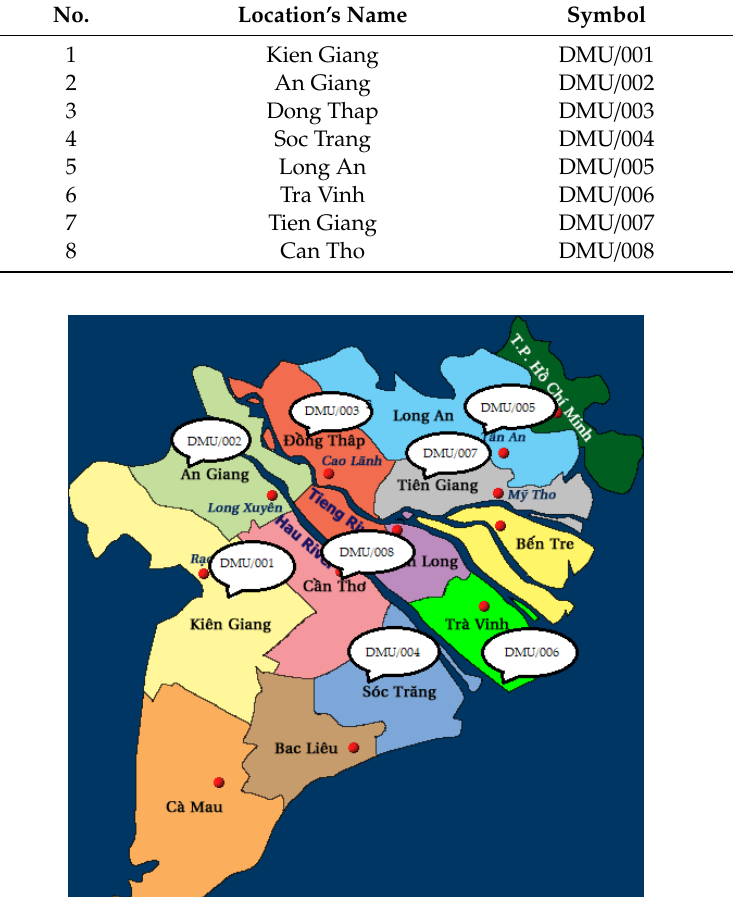
Figure 5. Mekong Delta map. Table 1. A potential locations list. DMU — decision making unit.